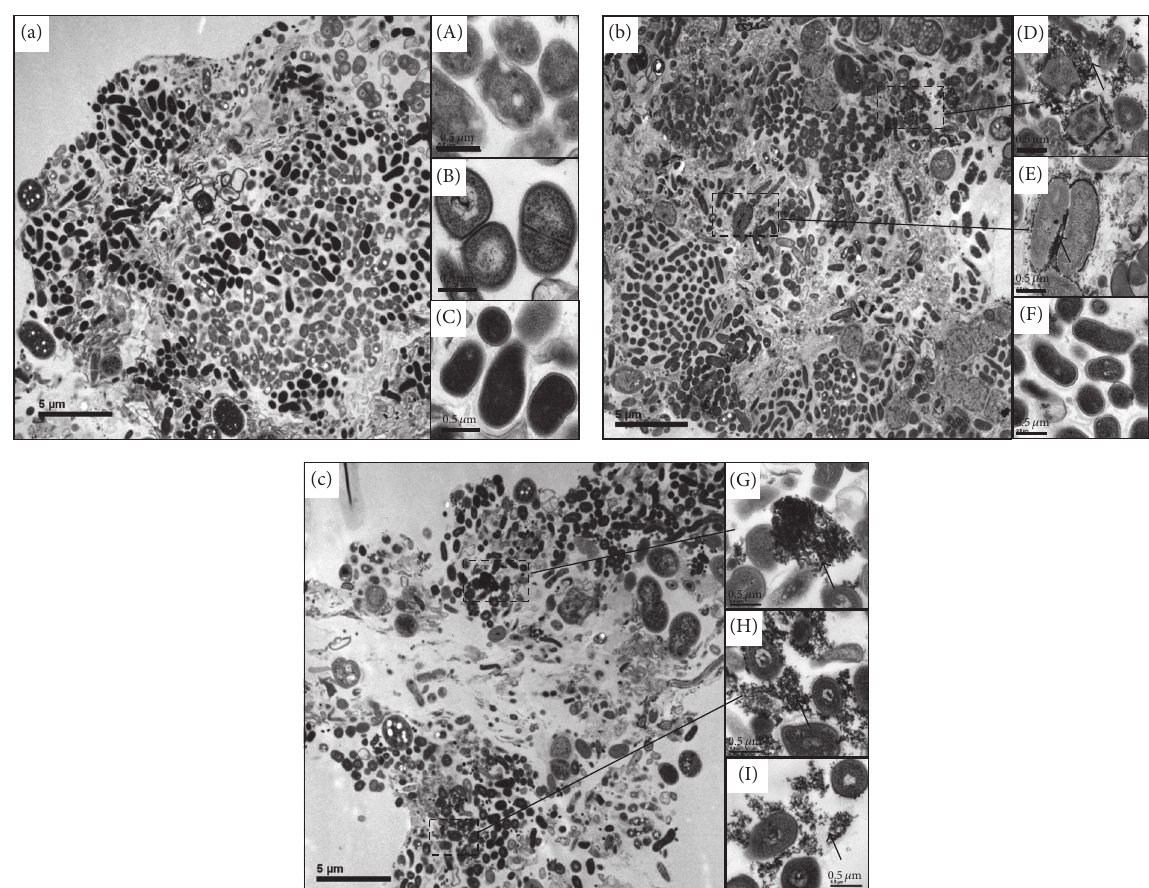
Figure 5: TEM image of sludge without (a) or with (b) the addition of 50 mg/L Fe 2 O 3 NPs after 6h. (a) Inset panels (A)–(C) and (D)–(F) show three kinds of bacteria in the sludge. In panel (c), the reaction was allowed to continue for 36 hours in the presence of Fe 2 O 3 NP. The insets (G)–(I) show bacteria at the 36 h time point. Arrows indicate Fe 2 O 3